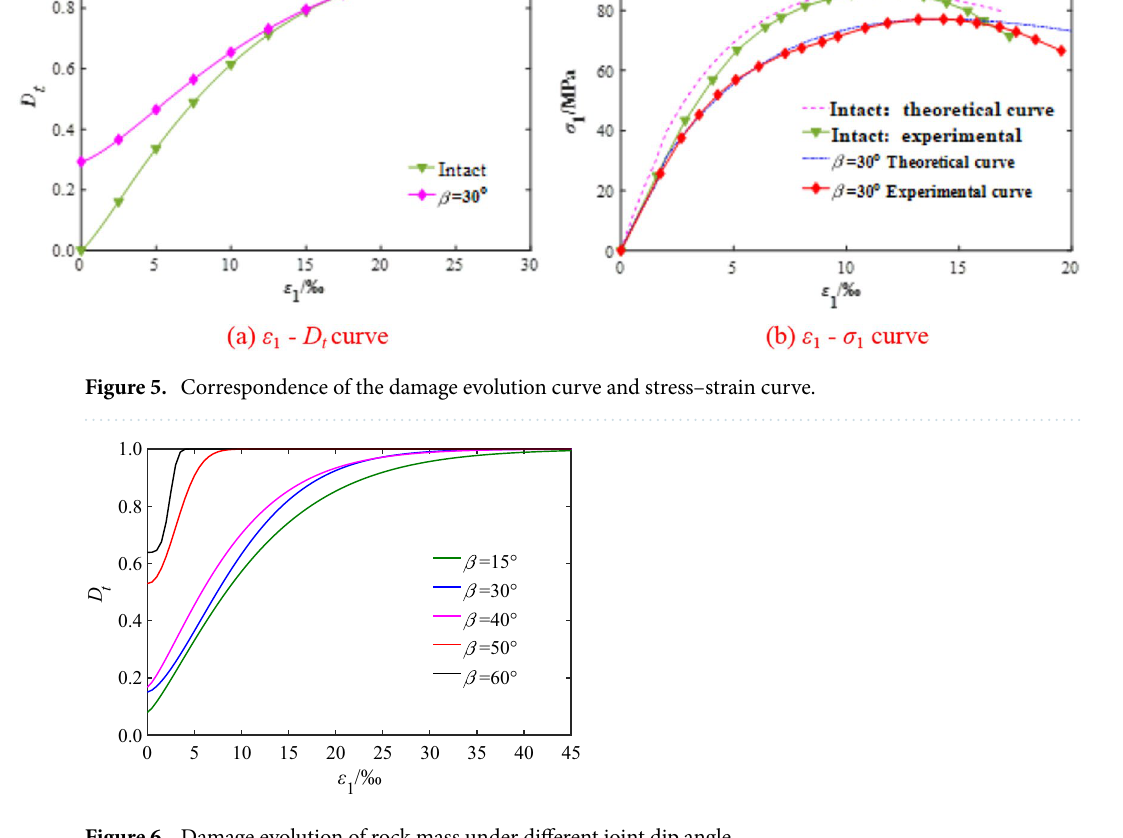
Figure 6. Damage evolution of rock mass under different joint dip